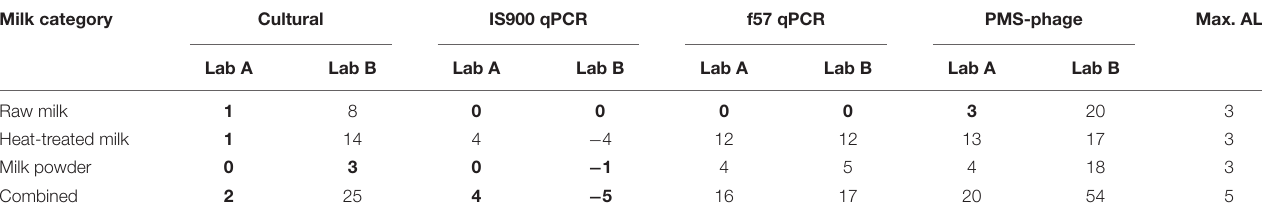
FIGURE 2 | Means of trueness values obtained in each laboratory for all dairy categories and methods. Error bars show the values obtained by laboratory A and laboratory B. TABLE 3 | Acceptance limits of the results obtained with all methods and dairy categories tested for the sensitivity study. Milk